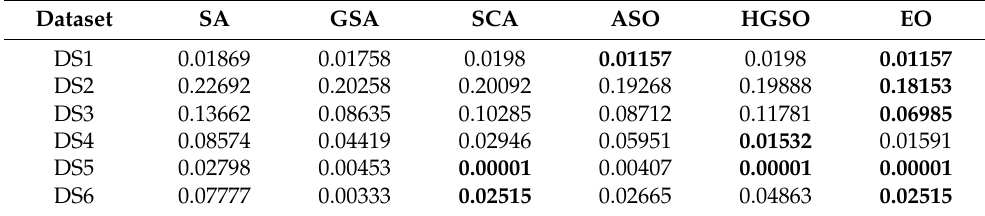
Table 3. Best fitness values of all